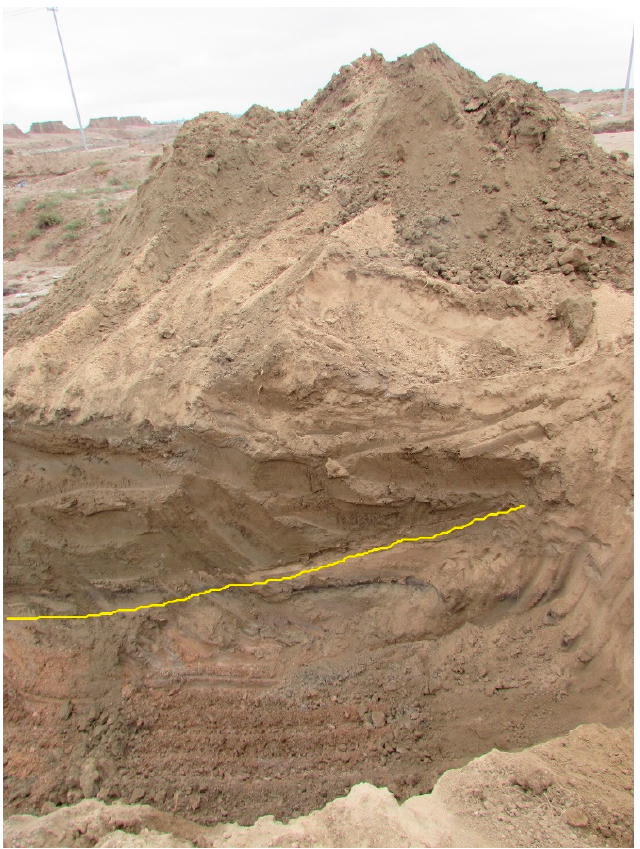
Figure 6. Trench J2 showing a cut through the natural pink sand of the landscape.